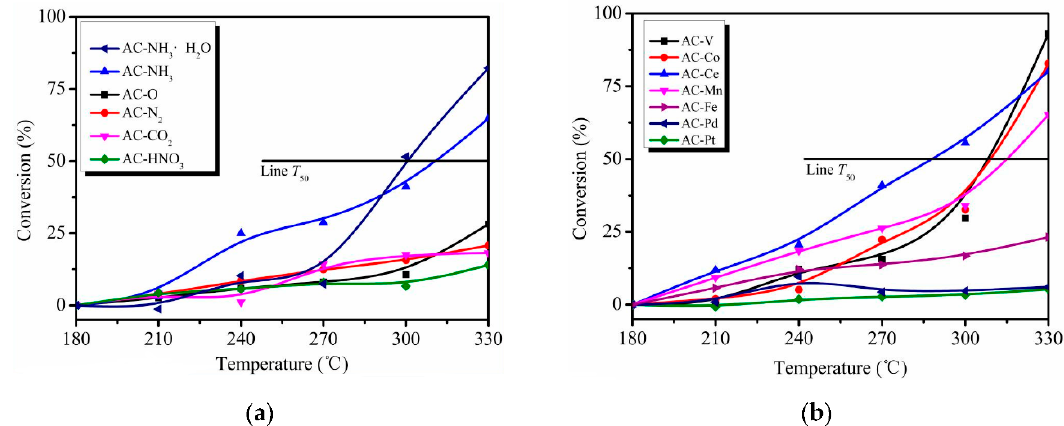
Figure 2. o -CP conversion as a function of temperature over different catalysts. Conditions: 200 ppm o -CP, the gaseous hourly space velocity (GHSV) of 95,000 h −1 ( a ) the chemical treated catalysts; ( b ) the metal modified catalysts.